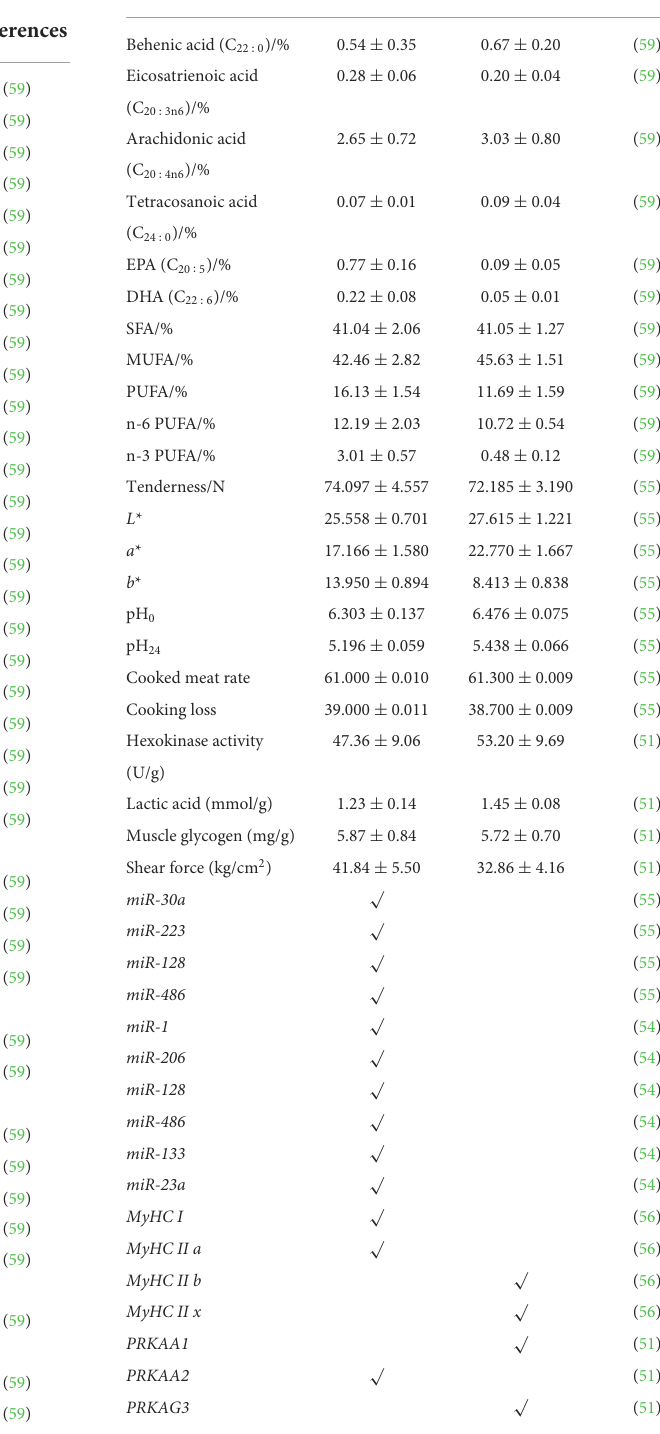
TABLE 1 Effects of feeding regimes on slaughter performance, carcass characteristics, meat quality, fatty acids, expression of skeletal muscle-related genes and miRNAs of Sunite sheep *